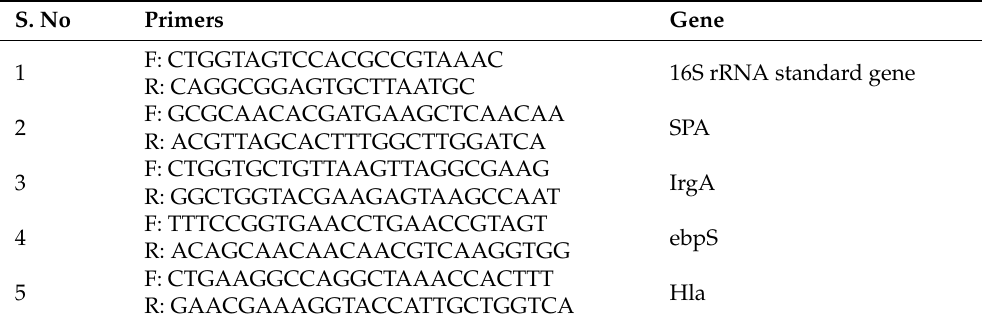
Table 1. Primers used for selective gene factors responsible for MRSA virulence, tested by